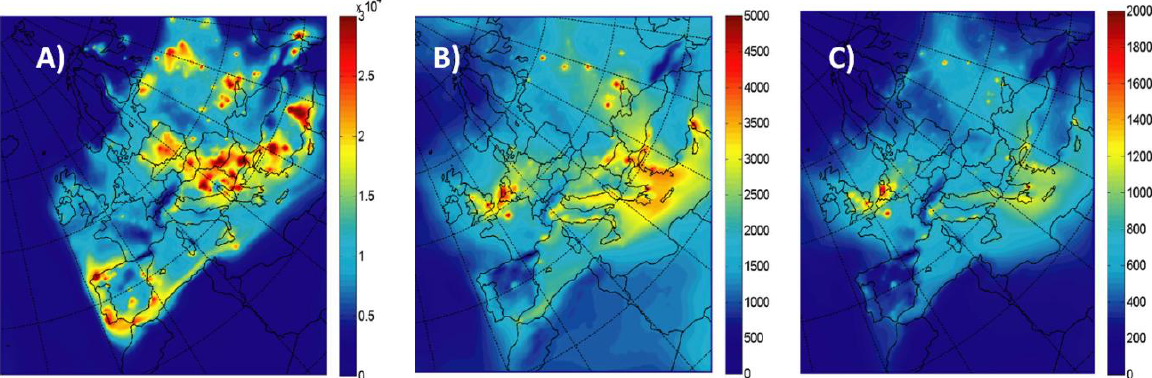
Fig. 15. The average number concentrations (cm − 3 ) at the ground level above (A) 3nm, (B) 50nm, and (C) 100nm as predicted by the